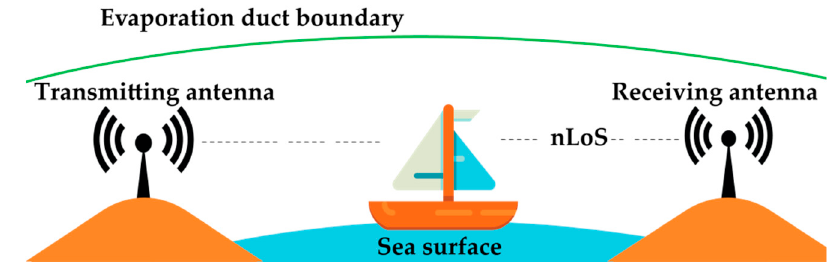
Figure 5. An example of a non-line-of-sight (nLoS) propagation pathway.